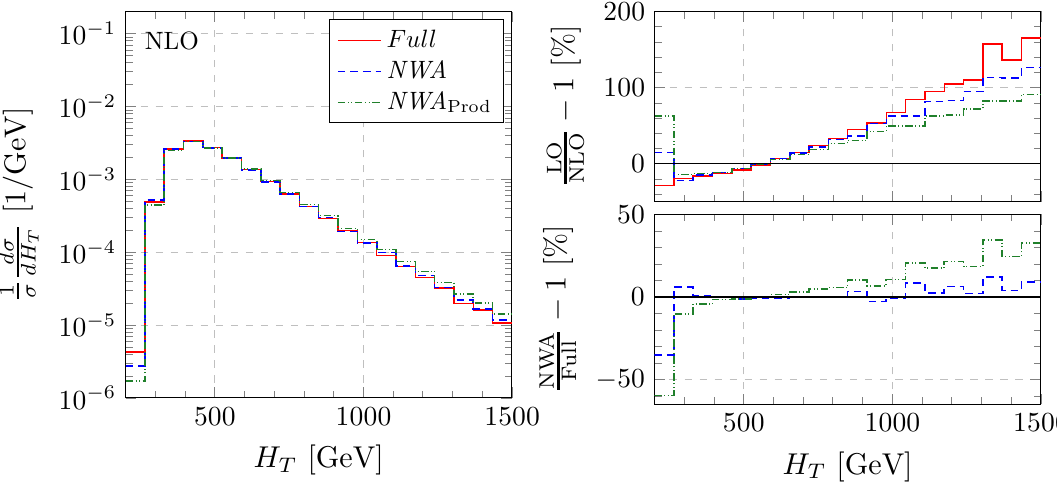
(cid:22) bj + + (cid:23) e (cid:22) (cid:0) (cid:22) (cid:23) (cid:22) b